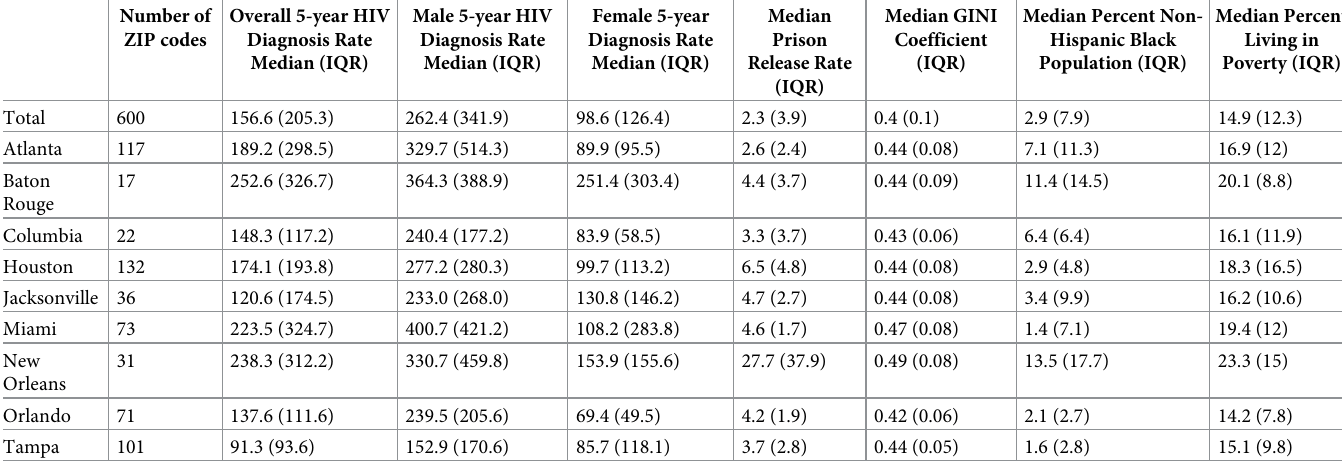
Table 1. Overall, male and female 5-year HIV diagnoses rates and independent variables by city. Number of Overall 5-year HIV ZIP codes Diagnosis Rate